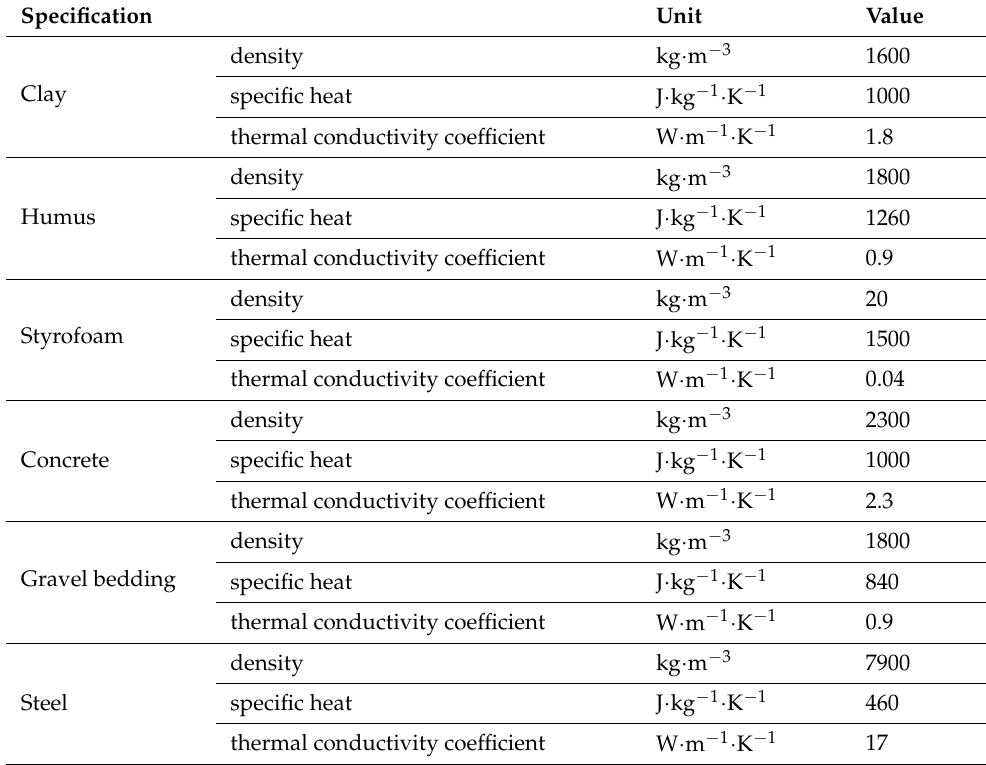
Table 1. Physical parameters of ground and construction materials of the cooling facility partitions used in